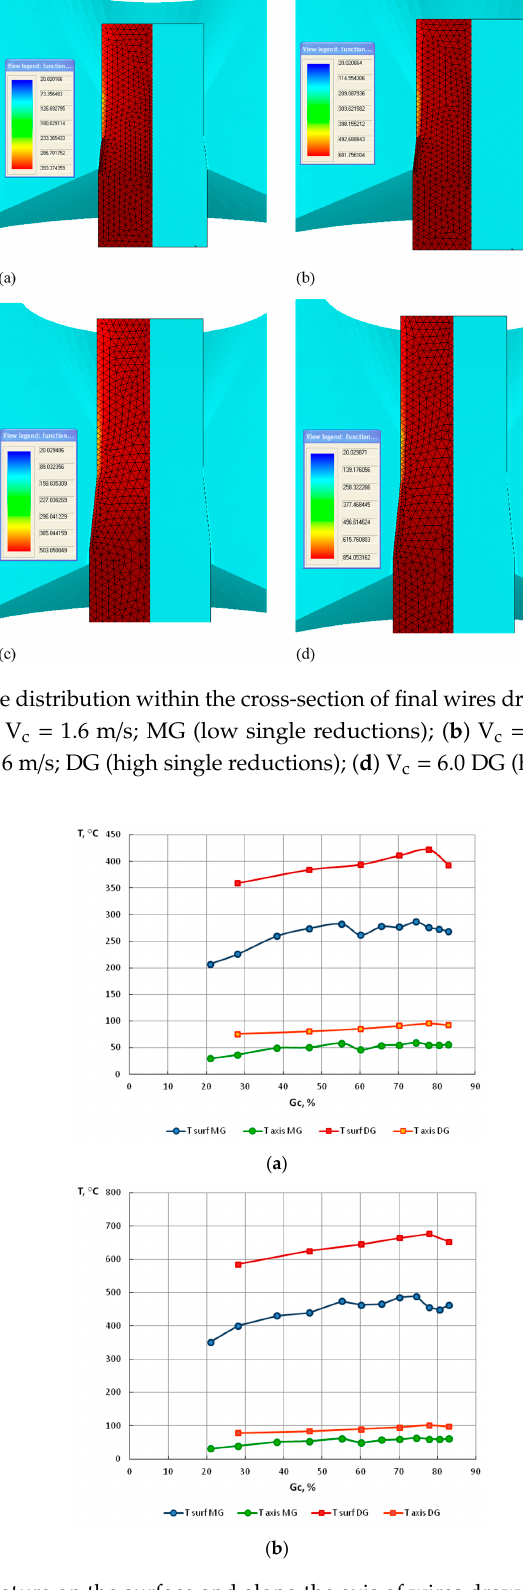
Figure 16. The temperature on the surface and along the axis of wires drawn with low (MG) and high (DG) single drawing reductions, at different drawing speeds, as a function of the total drawing reduction G c %. ( a ) V = 1.6 m/s ( b ) V = 6.0 m/s.